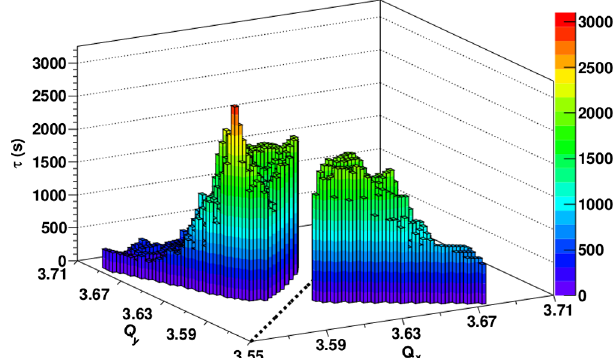
FIG. 12. Beam lifetime as a function of the betatron tunes Q and Q . The data from Fig. 11 are shown here again together with y additional data points in the central region close to Q coupling), which were obtained by an adjustment of sextupole magnets. The dashed lines correspond to j Δ Q split j ¼ 0 . 014 . Sum and difference resonances of the second, third, and sixth order are shown, representing the strongest multipole components of dipole and quadrupole magnets in the